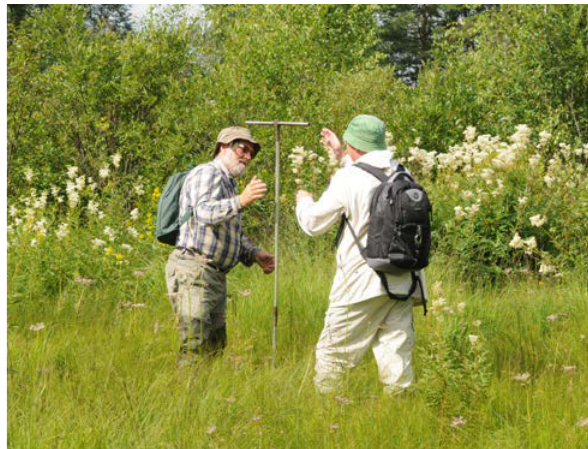
Figure 9. Rich flark fen in Mire 33 in 2007 (photo: Raimo Heikkilä).